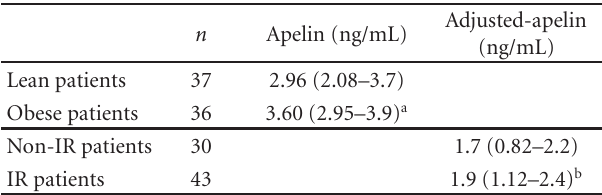
Table 4: Apelin and adjusted-apelin levels among di ff erent CHC groups ( n =